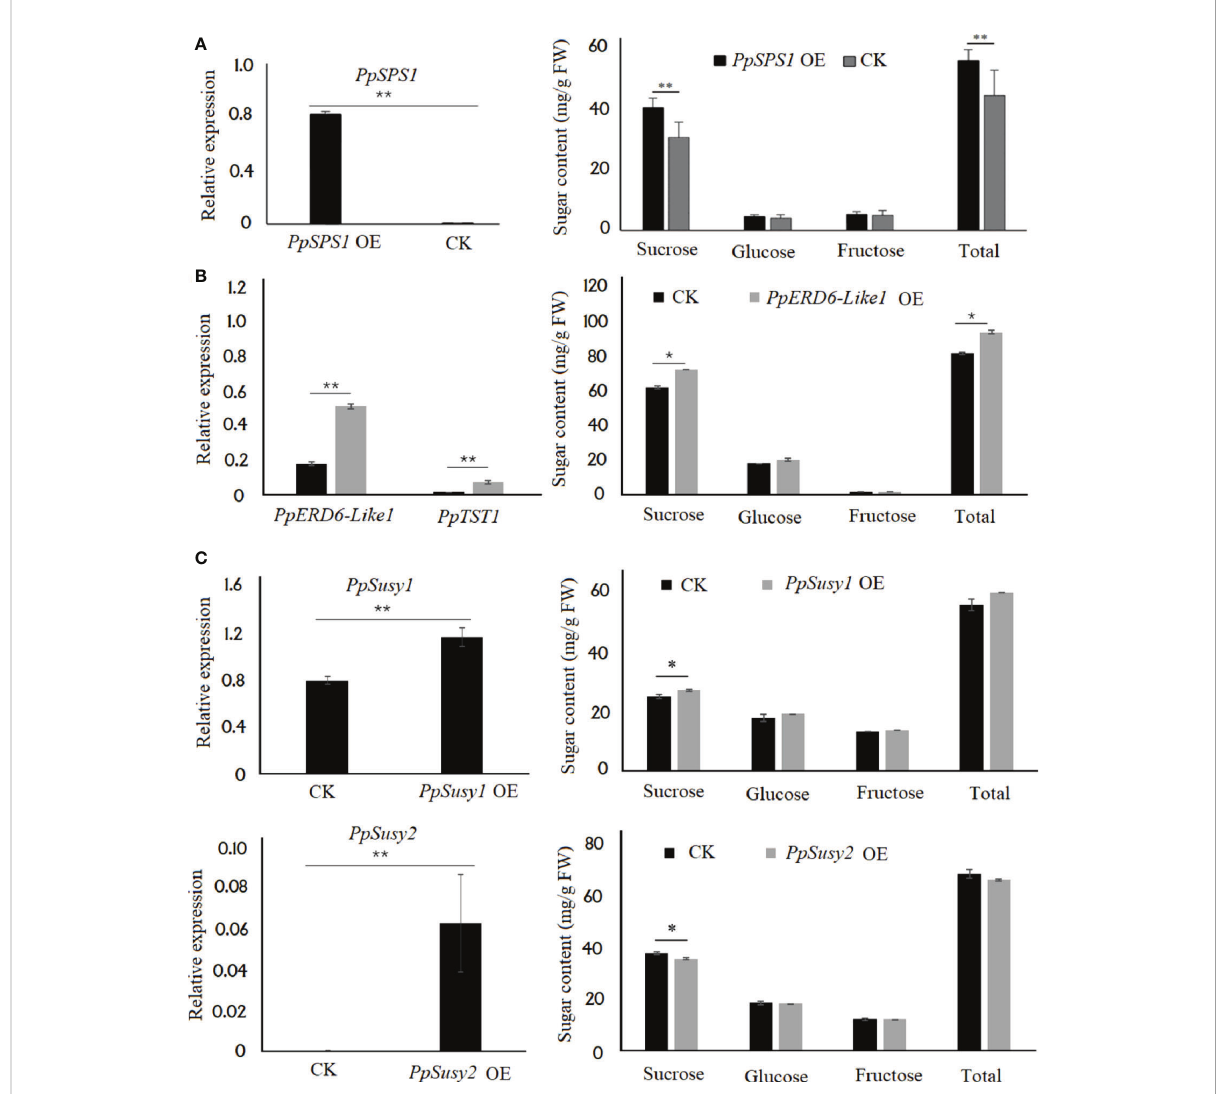
FIGURE 7 Functional analysis of sugar metabolism and transporter genes via transient overexpression in peach fruits at the ripening stage. (A) , Expression of PpSPS1 in the fl eshy tissues in fi ltrated with either PpSPS1 or empty vector (CK) (left), and sugar contents in the fl eshy tissues in fi ltrated with PpSPS1 or empty vector (right). (B) , Effect of overexpression of PpERD6-Like1 on sugar accumulation. Left, expression of PpERD6-Like1 and PpTST1 in the fl eshy tissues in fi ltrated with either PpERD6-Like1 or the empty vector. Right, sugar contents in the fl eshy tissues in fi ltrated with PpERD6-Like1 or empty vector. (C) , Effect of overexpression of the PpSusy genes on sugar accumulation. Left, Expression of the PpSusy genes in the fl eshy tissues in fi ltrated with either PpSusy or empty vector. Right, sugar contents in the fl eshy tissues in fi ltrated with PpSusy or empty vector. ** and * indicate statistical signi fi cance at P < 0.01 and P < 0.05, respectively, based on Student ’ s t